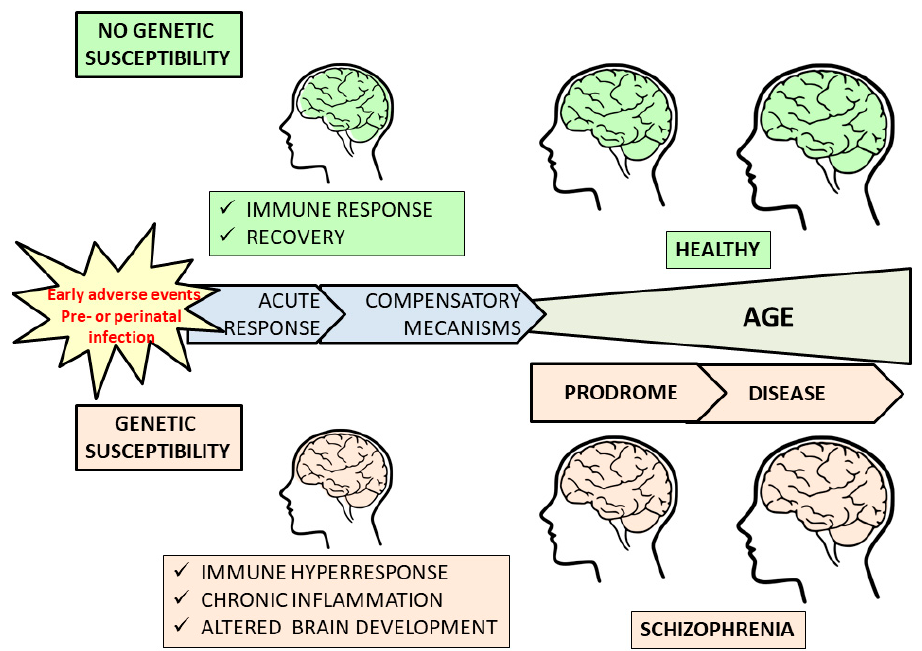
Figure 1. Schematic representation of the possible role of prenatal infections in schizophrenia pathophysiology. Exposure to neurotropic pathogens such as cytomegalovirus (CMV), other herpes viruses or T. gondii, or early adverse or stressful events has been proposed as environmental risk factors for schizophrenia in individuals with genetic susceptibility. Thus, maternal immune response to infection during pregnancy induce the production of pro-inflammatory cytokines, such as interleukin (IL)-6, IL-1, tumor necrosis factor (TNF)- α and interferon (IFN)- γ , which activate placenta, fetal blood vessel and meninges. Inflammation may transiently alter brain development that, in the absence of genetic susceptibility, recovers in a short period of time. However, in the presence of genetic susceptibility to schizophrenia, the fetal meninges and blood vessels are hyper-responsive to these cytokines by secreting more cytokines and chemokines, the compensatory mechanisms (e.g., gene expression changes induced by IFN- γ ) are exhausted and finally results in chronic inflammatory responses interfering with brain development. The inflammation status also influences postnatal brain development and the course of illness that after a prodrome phase finally results in schizophrenia. (Brain icon was obtained from: https://www.wpclipart.com/medical/anatomy/brain /brain_icon.png.html).